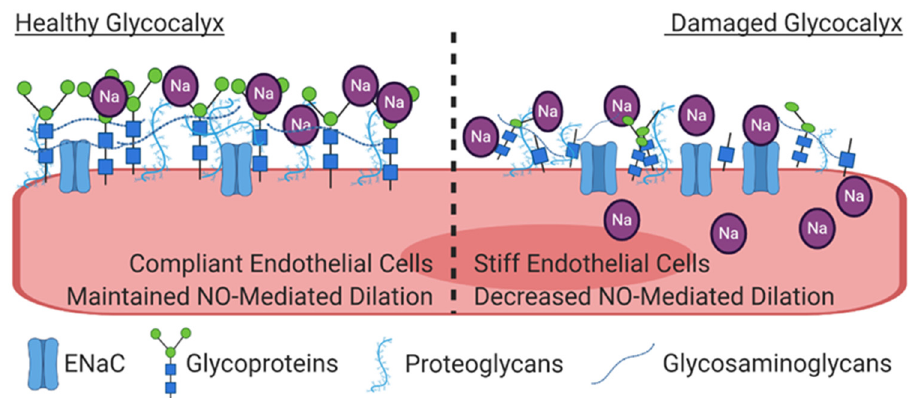
Figure 3. On the left, the healthy glycocalyx functions as a barrier between the plasma and the endothelial cell. The negatively charged glycocalyx buffers the positively charged sodium ions. On the right, increases in plasma sodium cause damage to the glycocalyx, thus increasing the access of sodium to epithelial sodium channels (ENaC) on the surface of the endothelium, leading to increased intracellular sodium concentrations. Under these conditions, the cell becomes stiffer, and the transduction of shear stress into NO release is decreased.